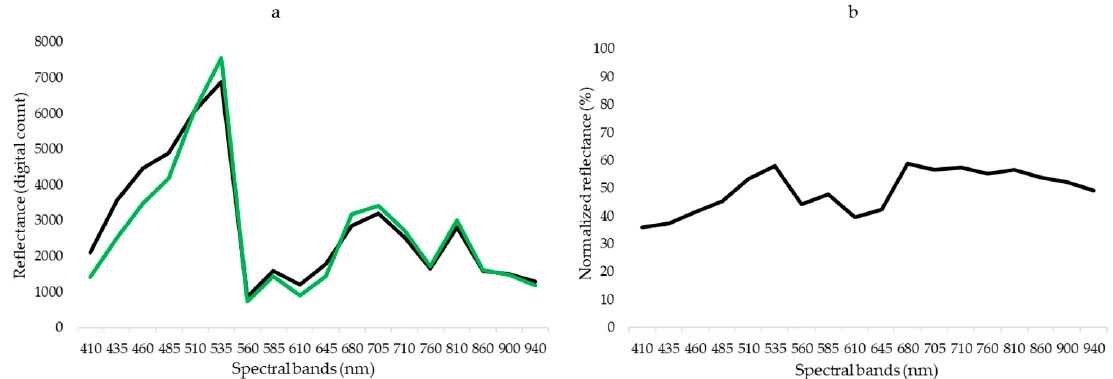
Figure 3. Pre- and post-processed spectrum (410–940 nm) of a given sample. ( a ) Raw spectrum of the known reflectance surface (black), and raw spectrum of the given sample (green). ( b ) Calibrated spectrum of the given sample based on the reflectance of the known reference surface.